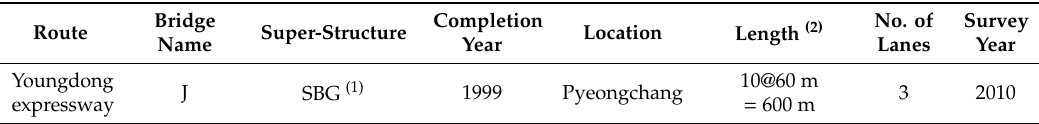
Table 2. General information of the pilot target bridge (“J” bridge) for field survey.